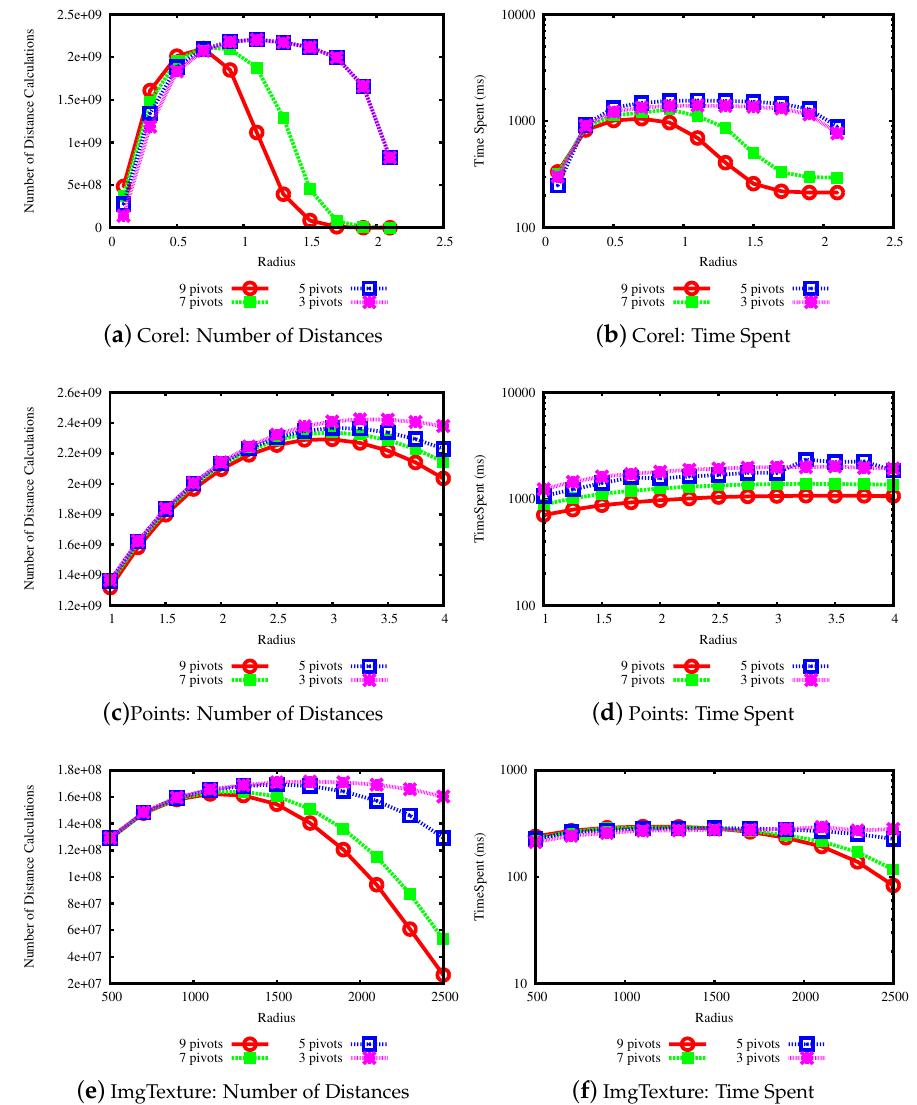
Figure 11. Performance of similarity joins for LUBJOIN varying the number of pivots. ( a , c , e ) the average of the number of distances calculated in queries. ( b , d , f ) the time spent for performing the queries